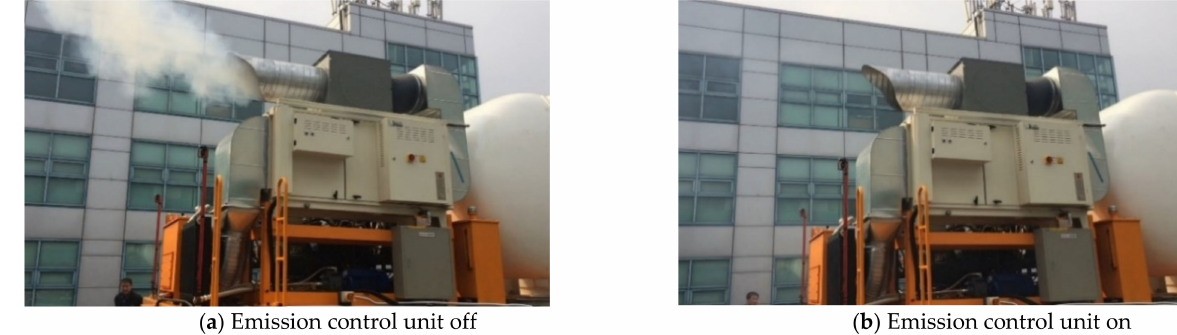
Figure 2. Heating equipment with the emission hood